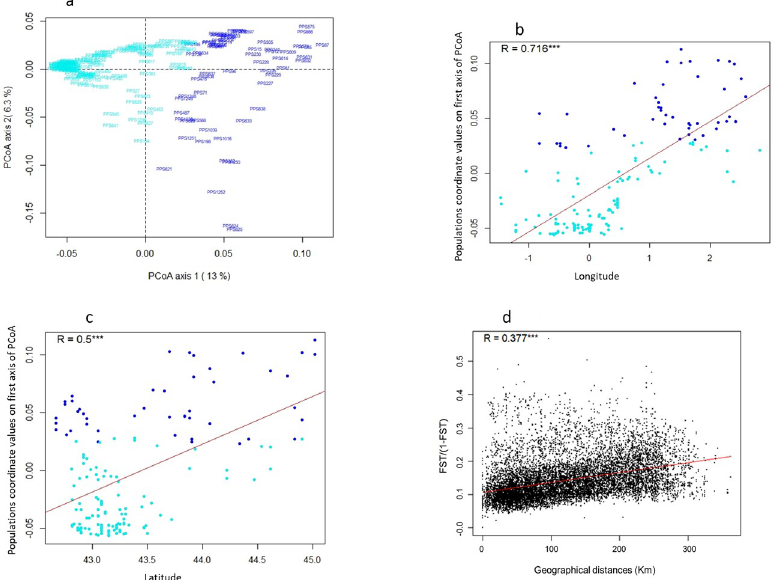
Fig 3. Spatial genetic structuration analysis of SWF landraces. (a) Principal coordinate analysis on SNP data using Rogers ‘genetic distance matrix estimated among the 194 landraces. (b) Longitudinal and (c) latitudinal gradient analyses on SNP data of 158 landraces from South-West France using coordinates values on the first axis of PCoA analysis. SWF landraces were colored according to their assignation to E-SWF and W-SWF groups identified with admixture analysis at K = 2. (d) Isolation by distance (IBD) analysis of 158 landraces from South-West France using F ST / (1- F ST ) matrix for genetic differentiation estimated following Rousset [32] and geographical distance matrix estimated for each pair of landraces. R = coefficient of correlation. ��� = p-value < 0.001.